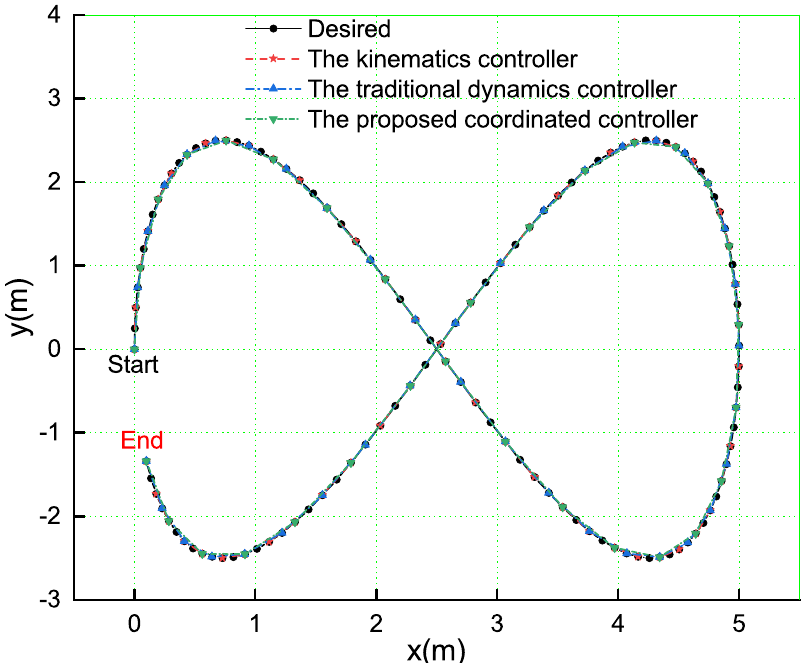
Figure 9. The simulation results for the inverted octagonal type trajectory tracking performance.